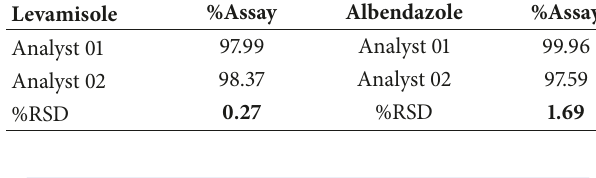
Figure13:Chromatogramoflevamisoleandalbendazolerobustness (0.8